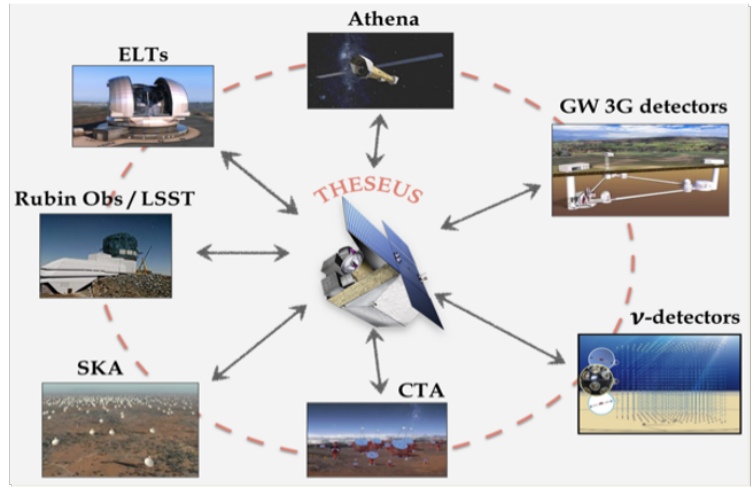
Figure 2. Synergy of THESEUS with next generation very large facilities in the multi-wavelength and multi-messenger domains [26].